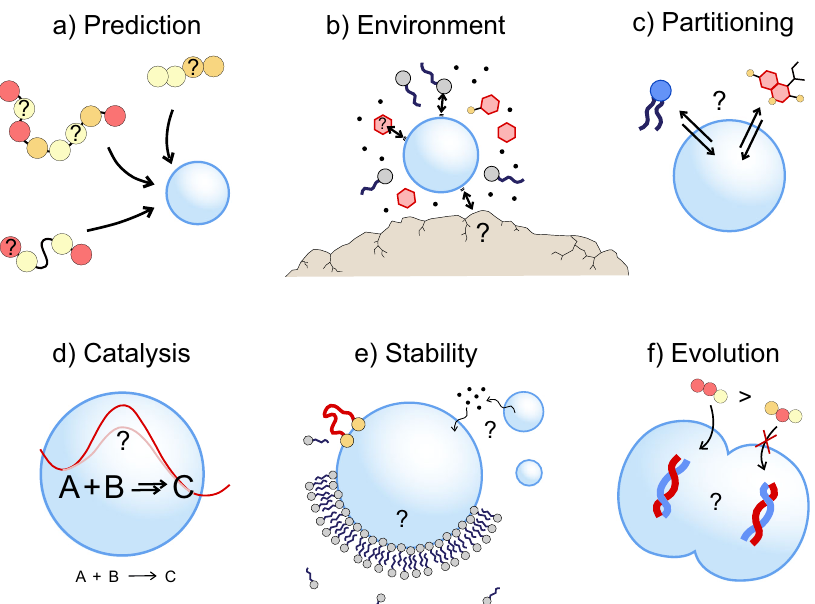
Fig. 1 Open questions on phase-separated droplets and the origins of life. An increasing range of small molecules has been found to undergo LLPS to form coacervate protocells, but predicting a priori a the coacervation of molecules and b the role of environmental factors remains dif fi cult. A molecular understanding of c partitioning and d catalysis inside coacervate droplets is lacking. Better understanding of e coacervate stability and the molecular structure of the interface would help to develop f increasingly complex, robust coacervate protocells that might ultimately proliferate and